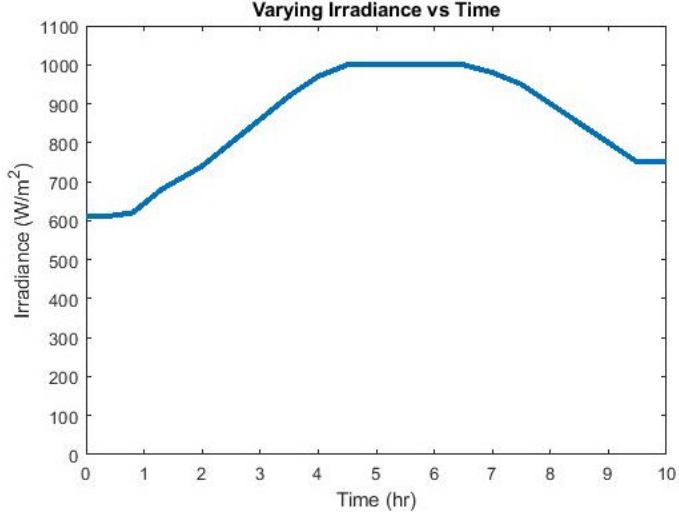
Figure 11. Varying solar irradiation.